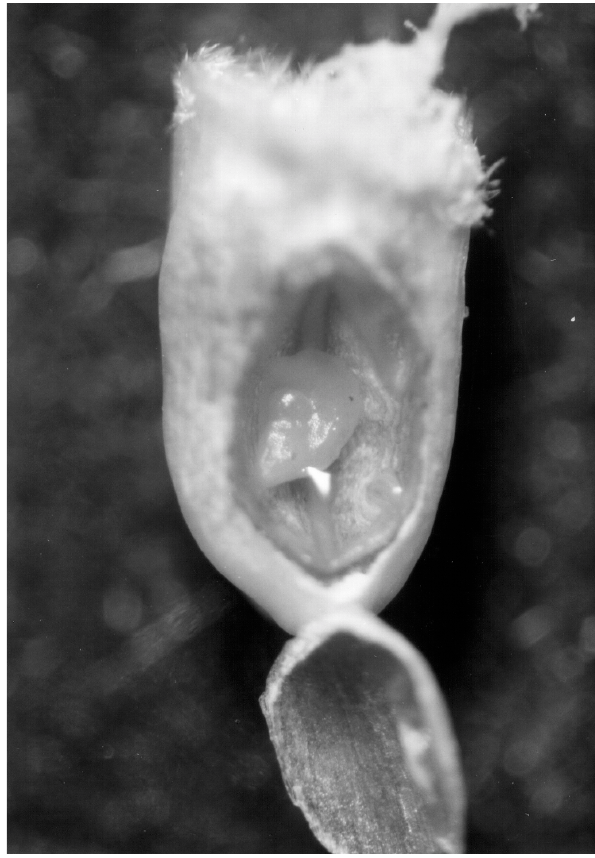
Figure 1 - Embryo formation through wheat x maize hybridization, 14 days after pollination. Note the embryo floating in a liquid not characterized as